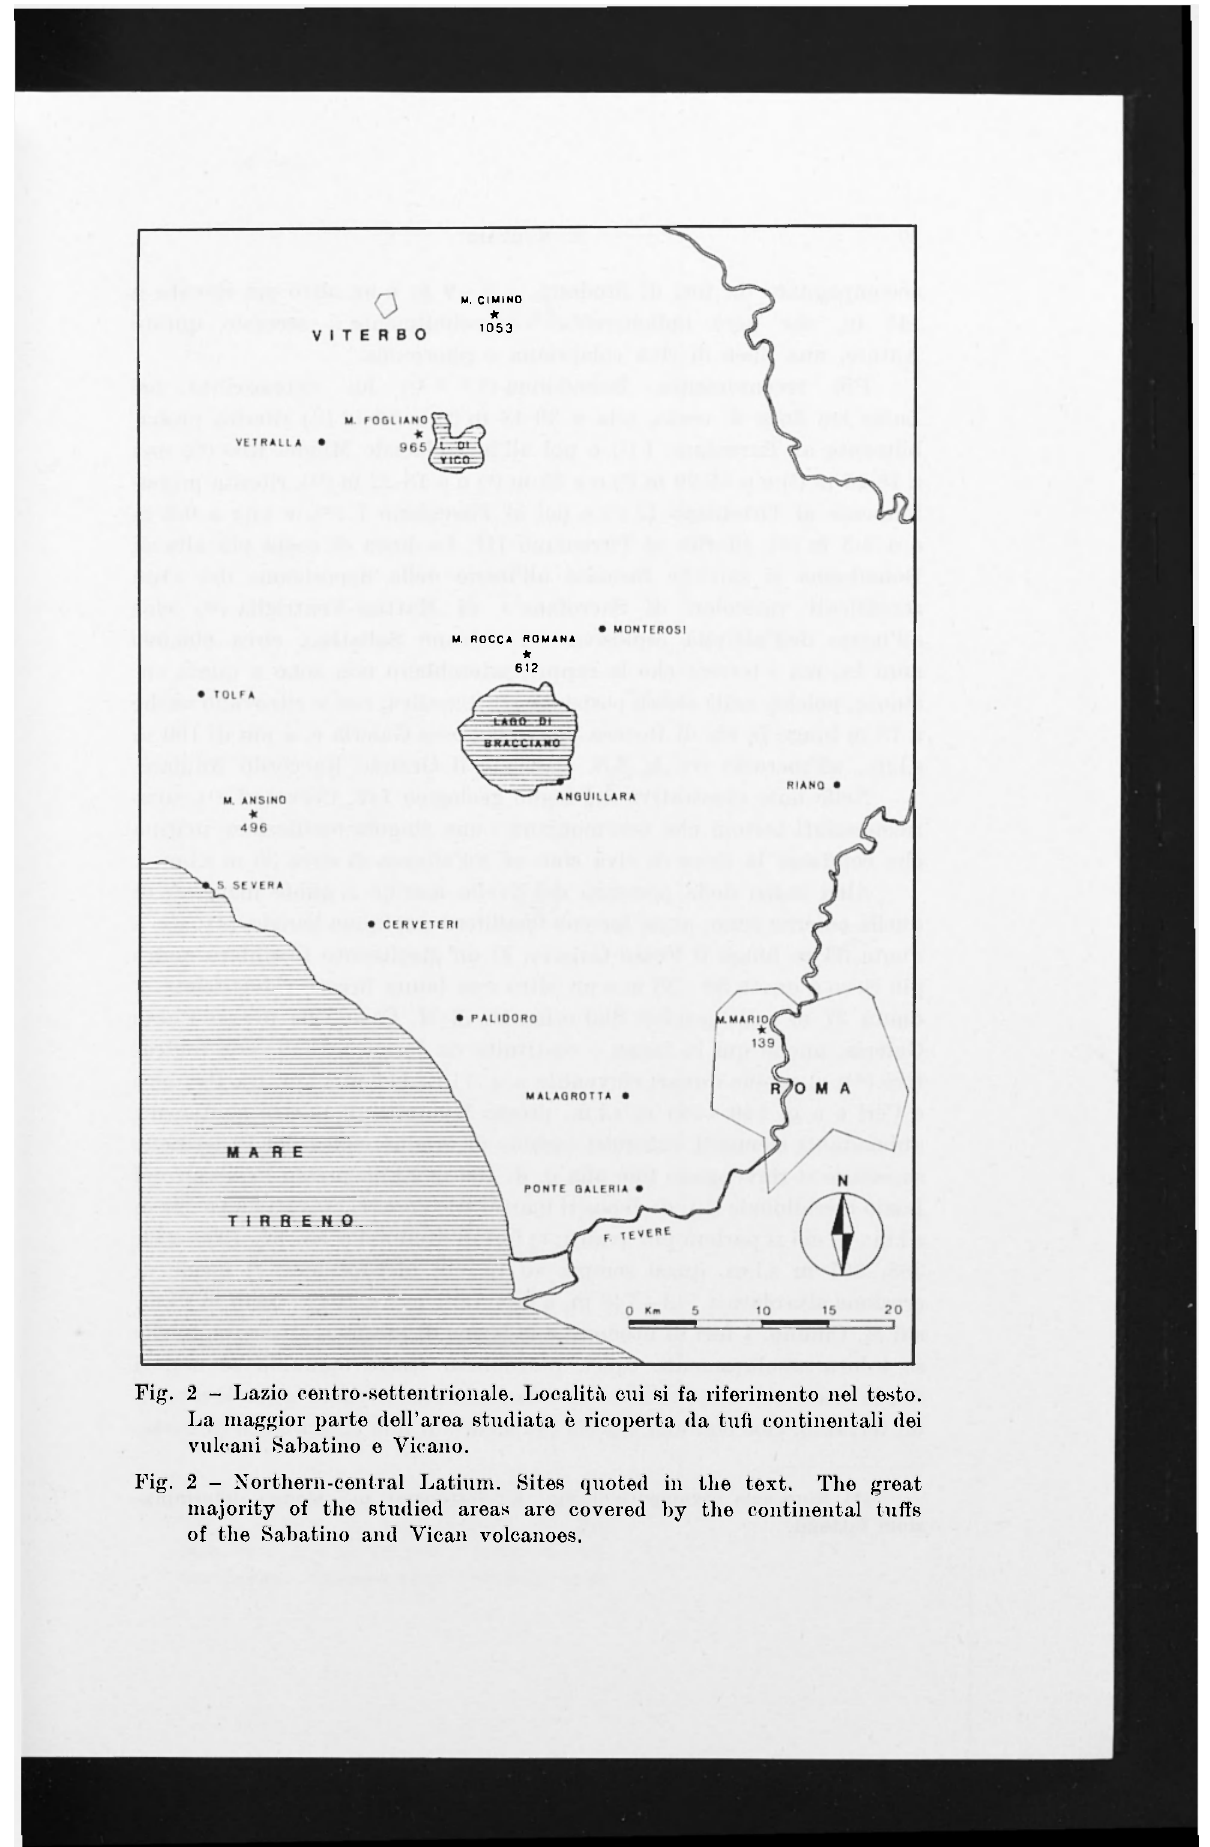
Fig. 2 - Lazio centro-settentrionale. Località cui si fa riferimento nel testo. La maggior parte dell'area studiata è ricoperta da tufi continentali dei vulcani Sabatino e Vicano. Fig. 2 - Northern-central Latium. Sites quoted in the text. The great majority of the studied areas are covered by the continental tuffs of the Sabatino and Yican